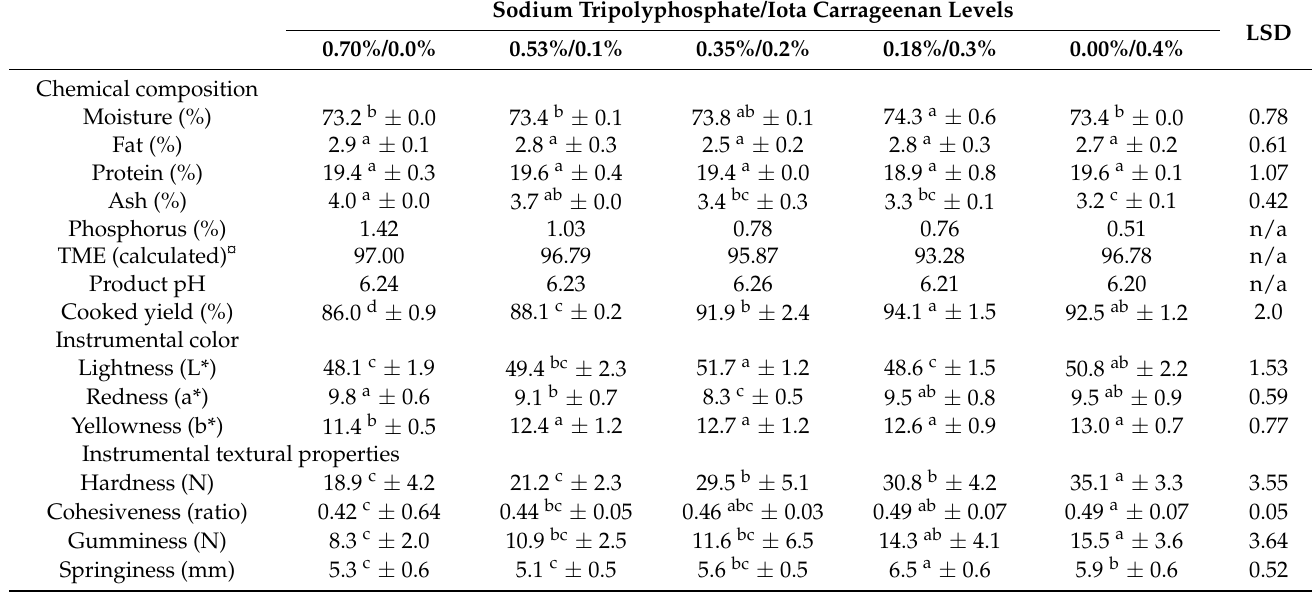
* Statistical analyses were performed on all data except for phosphorus, TME (Total Meat Equivalent: % Lean Meat Equivalent + % Total Fat) and pH, as these were measured/calculated only once per treatment; SD, Standard Deviation; LSD, Least Significant Difference ( p = 0.05); a–d Means within the same row with different superscripts differ significantly ( p ≤ 0.05), where L* represents white (100) to black (0), a* represents green ( − ve values) to red (+ve values) and b* represents blue ( − ve values) to yellow (+ve